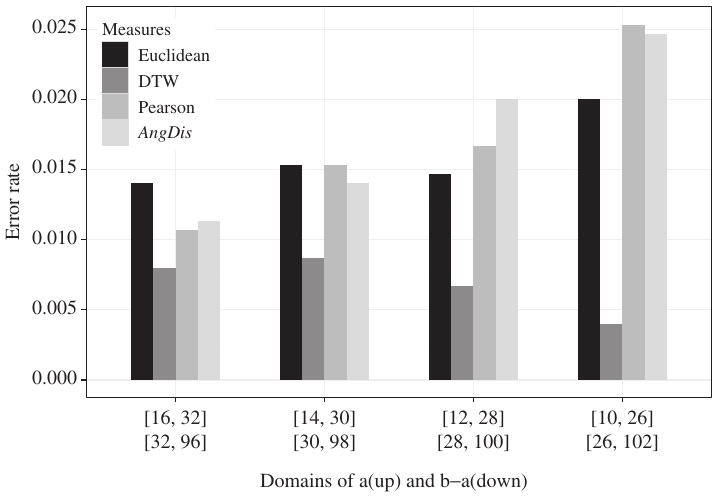
Figure 6. Experimental Results After Changing the Domains From Which a and ( b – a ) Are